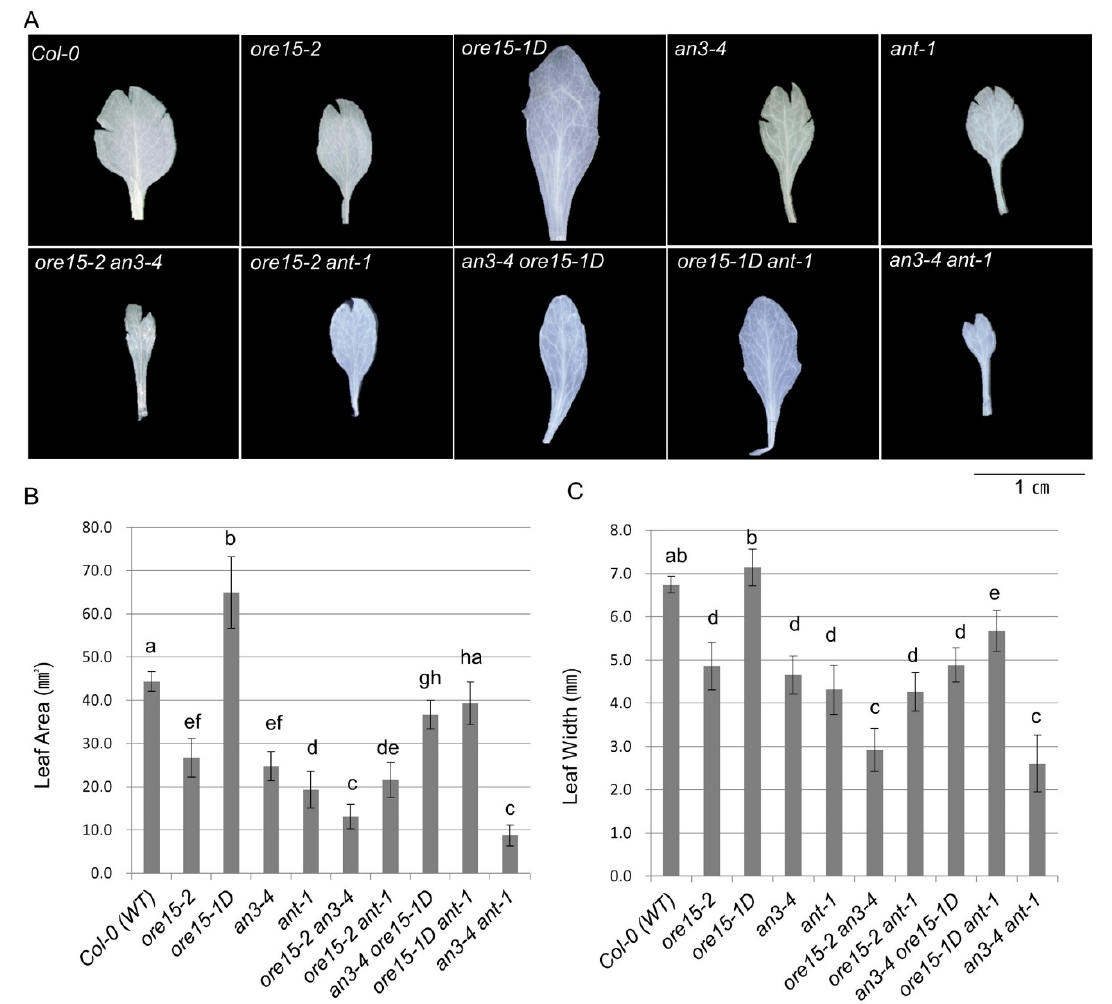
Figure 3. Leaf morphology of the mature third leaf from Col-0 (WT), single mutant, and double mutant plants at 21 DAS. ( A ) Phenotype of the mature third leaf detached from Col-0, single mutant, and double mutant plants at 21 DAS. Scale bar = 1 cm. ( B ) Leaf area. ( C ) Leaf width. Data are means ± standard error (SE) (7 ≤ n ≤ 10). Means were compared using one-way analysis of variance (ANOVA) followed by Duncan’s multiple range test. Different lowercase letters indicate significantly different means between genotypes.